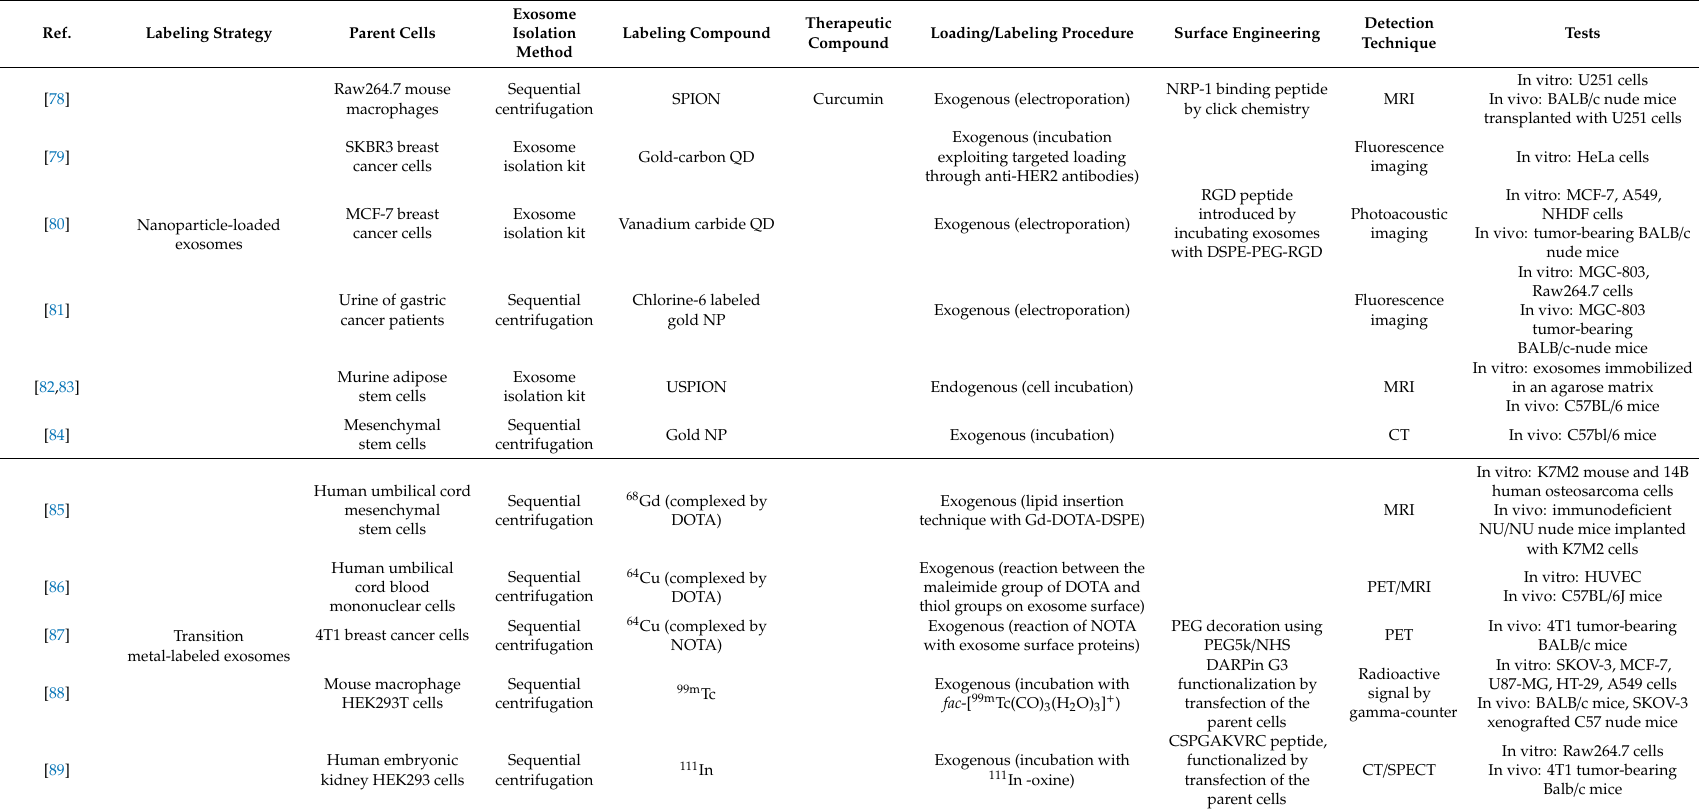
Table 1. Theranostic platforms based on exosomes, classified by loading